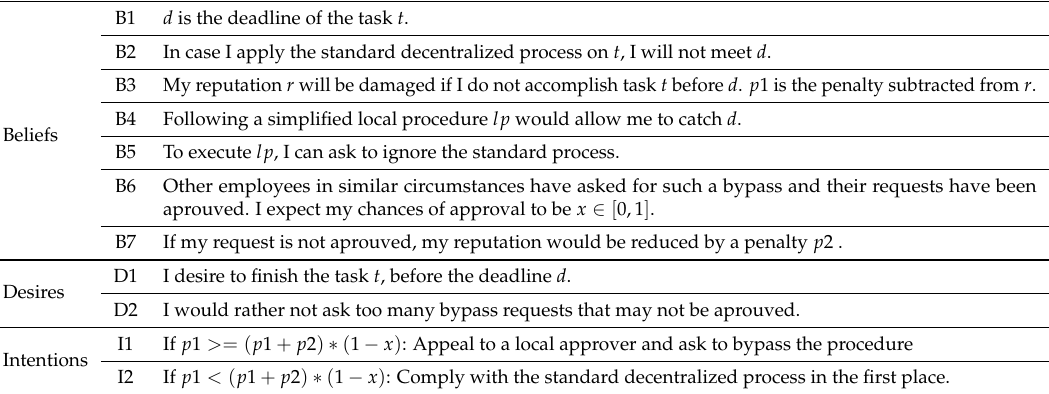
Beliefs, desires and intentions of a belief–desire–intention (BDI) agent representing an